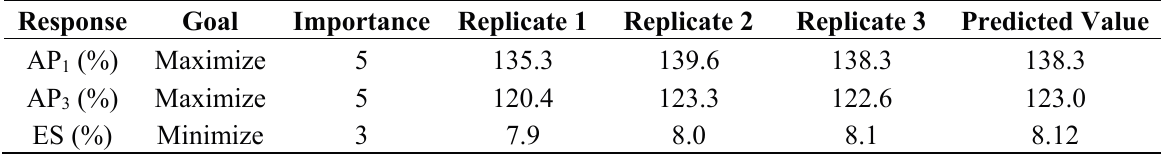
Table 5. Responses for optimization and verification